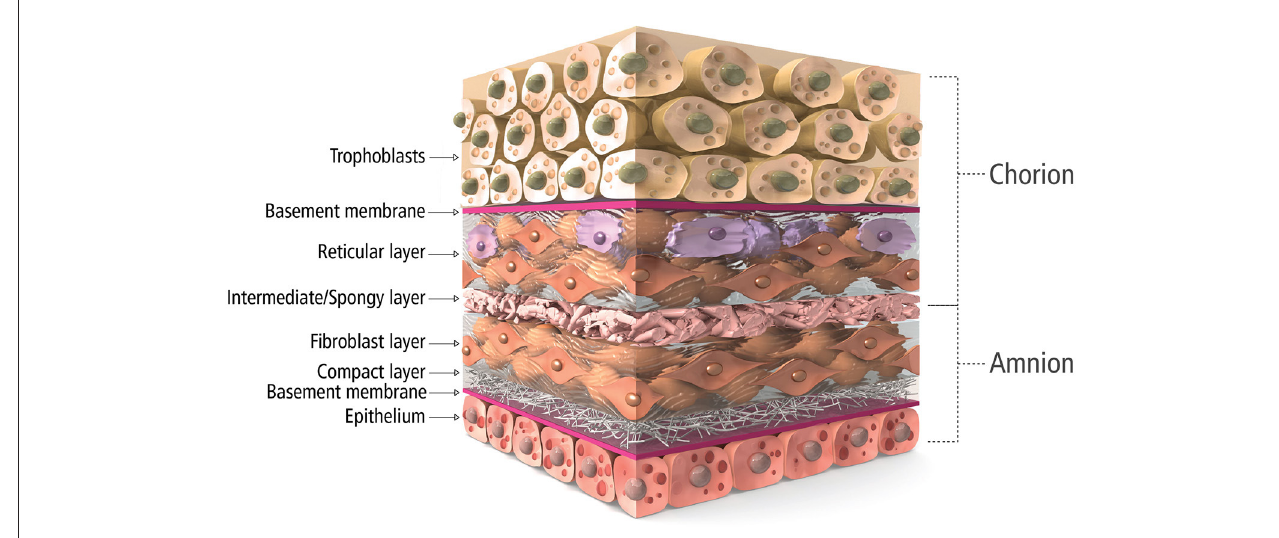
FIGURE 1 | Cross-sectional schematic of placental tissue